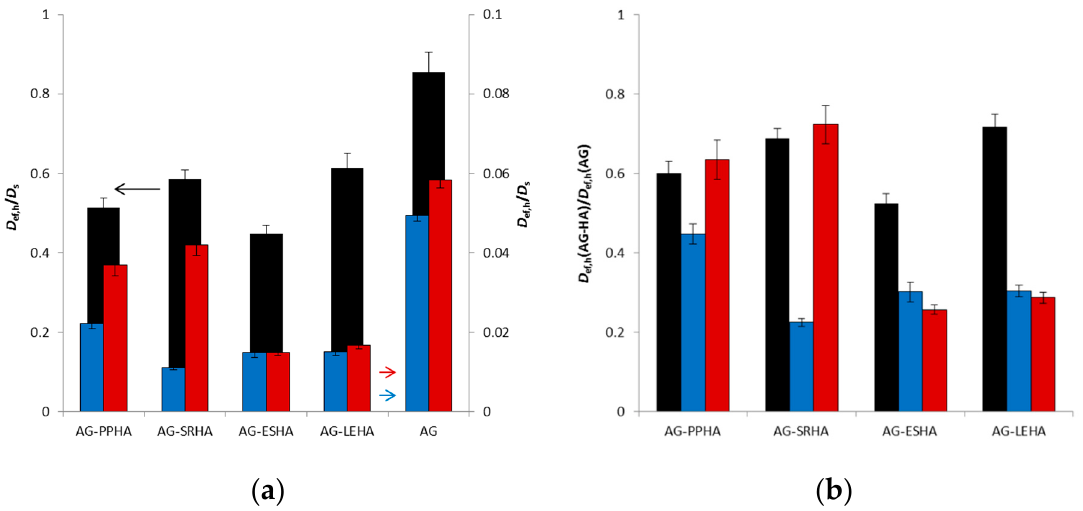
Figure 2. The ratios between effective diffusion coefficients D ef,h and the diffusion coefficients of probes in aqueous solutions D s ( a ); the ratios between effective diffusion coefficients D ef,h for AG-HA hydrogels and the values obtained for pure AG hydrogel ( b ): Cu (black); MB (blue); and RH (red).